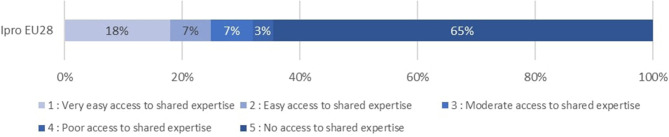
Support/access to shared expertise.